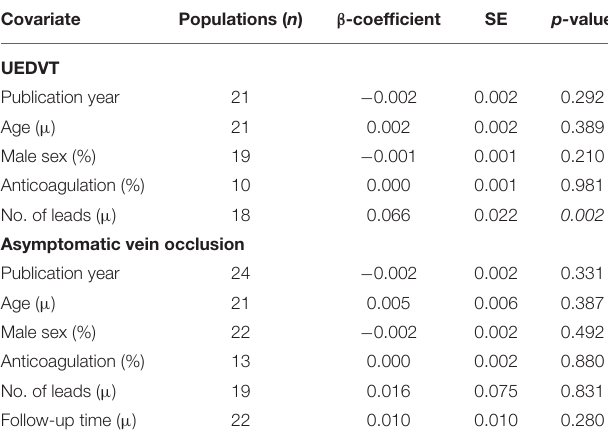
TABLE 3 | Univariate meta-regression for UEDVT and asymptomatic vein